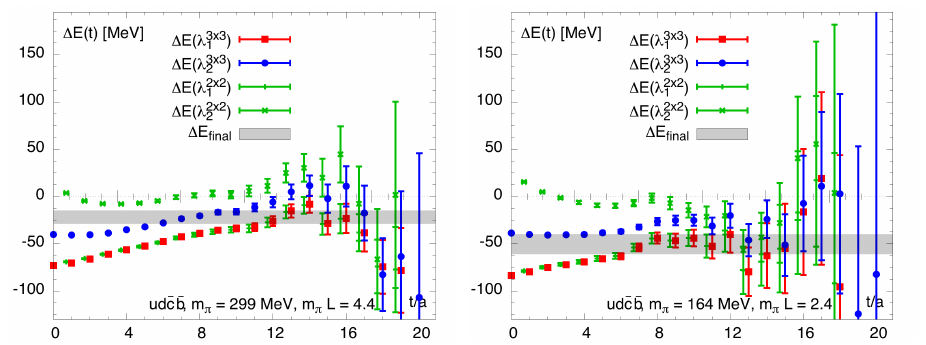
Figure 3. ud ¯ c ¯ b tetraquark results for binding energies at m π = 299 MeV (left) and m π = 164 MeV (right). Red squares and blue circles denote 3 × 3 GEVP ground and first excited state results, re- spectively, green vertical dashes and green diagonal crosses ground and first excited state 2 × 2 GEVP results. The grey bands depict the final binding energies, derived from single-exponential fits to the first eigenvalues. Further details may be found in [4], 2 × 2 GEVP results are o ff set slightly in t